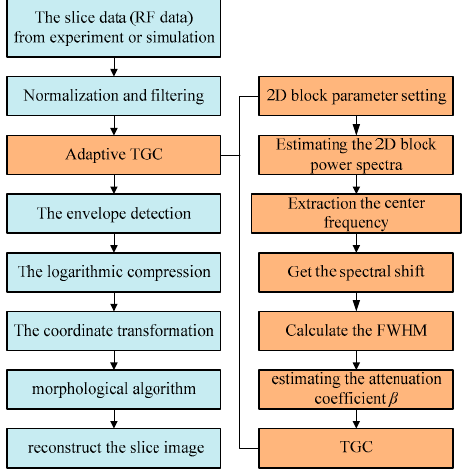
Figure 2. The breast ultrasound image reconstruction flow chart.